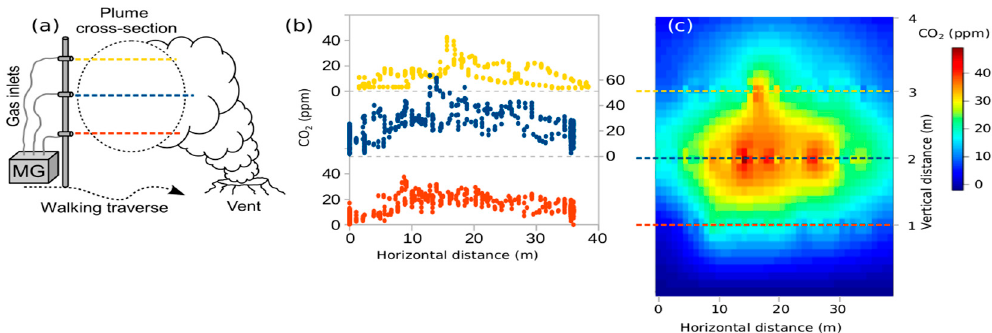
Figure 4. ( a ) MultiGAS setting for measuring gas concentrations between 1 to 3 m above the ground along a traverse perpendicular to the plume’s main axis and resulting ( b ) CO 2 concentration profiles crossing G56 volcanic plume acquired on 10 May 2016. ( c ) Calculated fitting surface interpolating CO 2 concentrations.